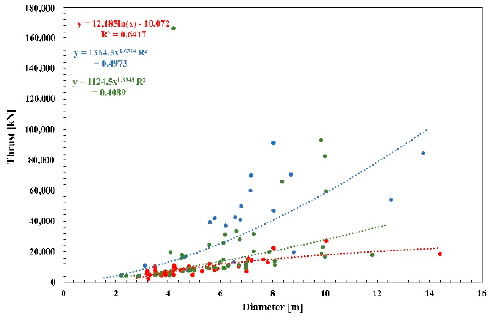
Figure 3. Correlation between diameter and thrust. Red: open TBM; blue: single shield TBM; green: double shield TBM.